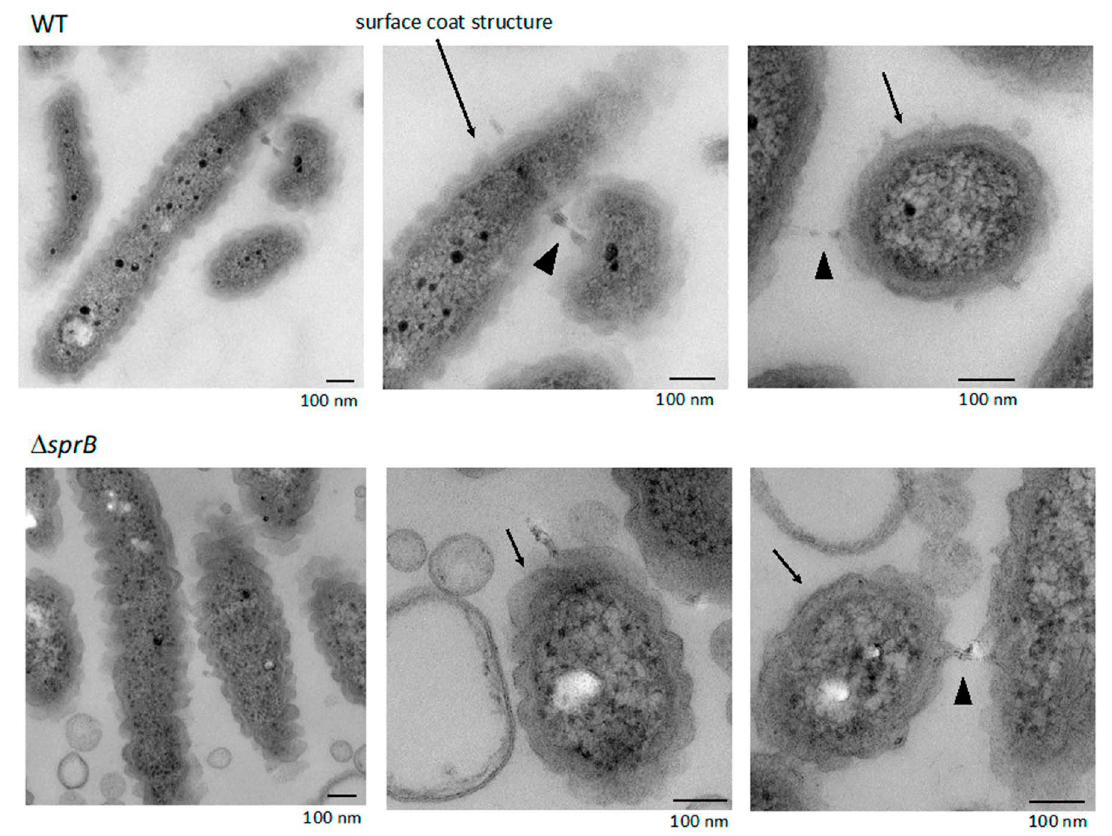
Figure 7. WT and ∆ sprB mutant cells on 1% A-PY2 embedded in Epon imaged by TEM. Embedded cells were 70 nm thin-sectioned. High-magnification images of cells pictured in Figure 1a. Each cell in the bacterial layer on the agar surface had a thick layered coat structure (arrows). The coat structure had regular undulations along the long and short axes, and was often in contact with the coat of the neighboring cells (arrowheads).